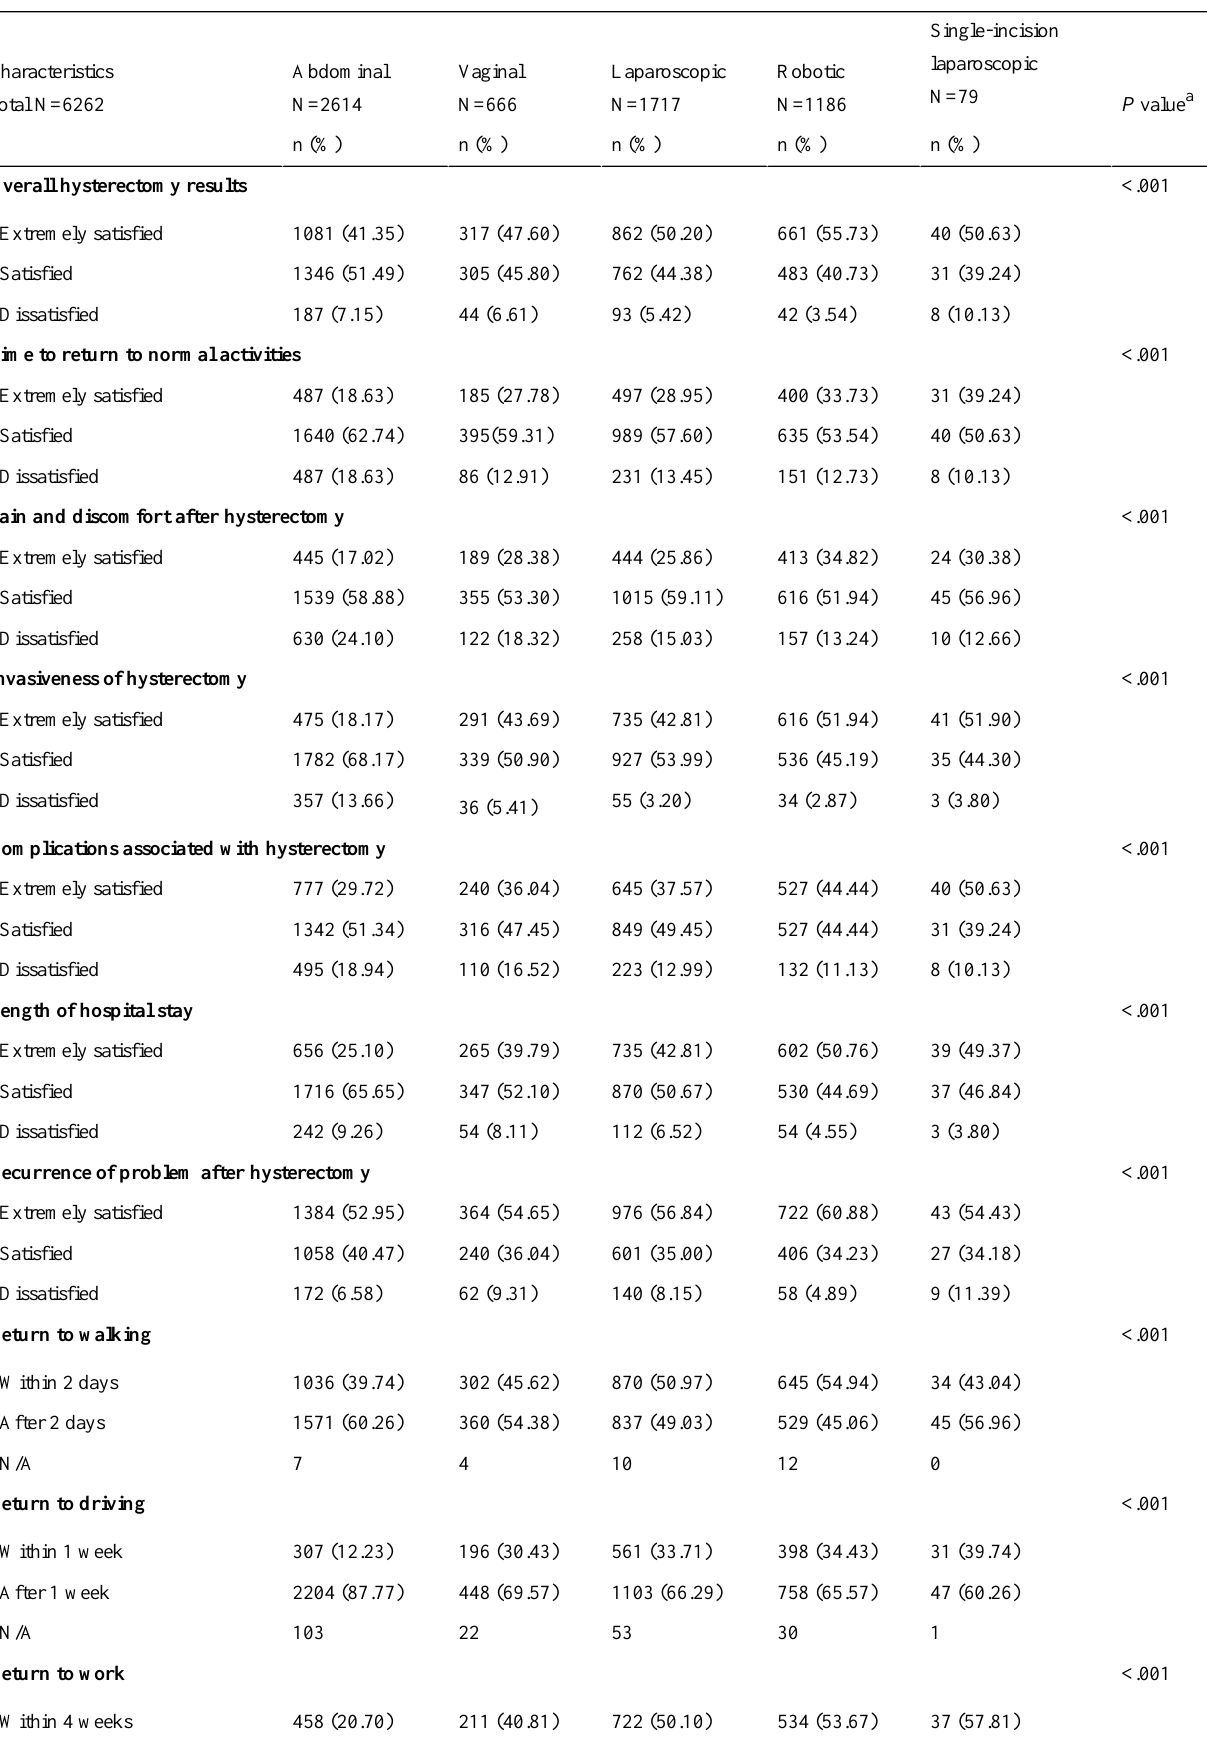
Table 2. Patient satisfaction, recovery, and recommendations by surgical technique.